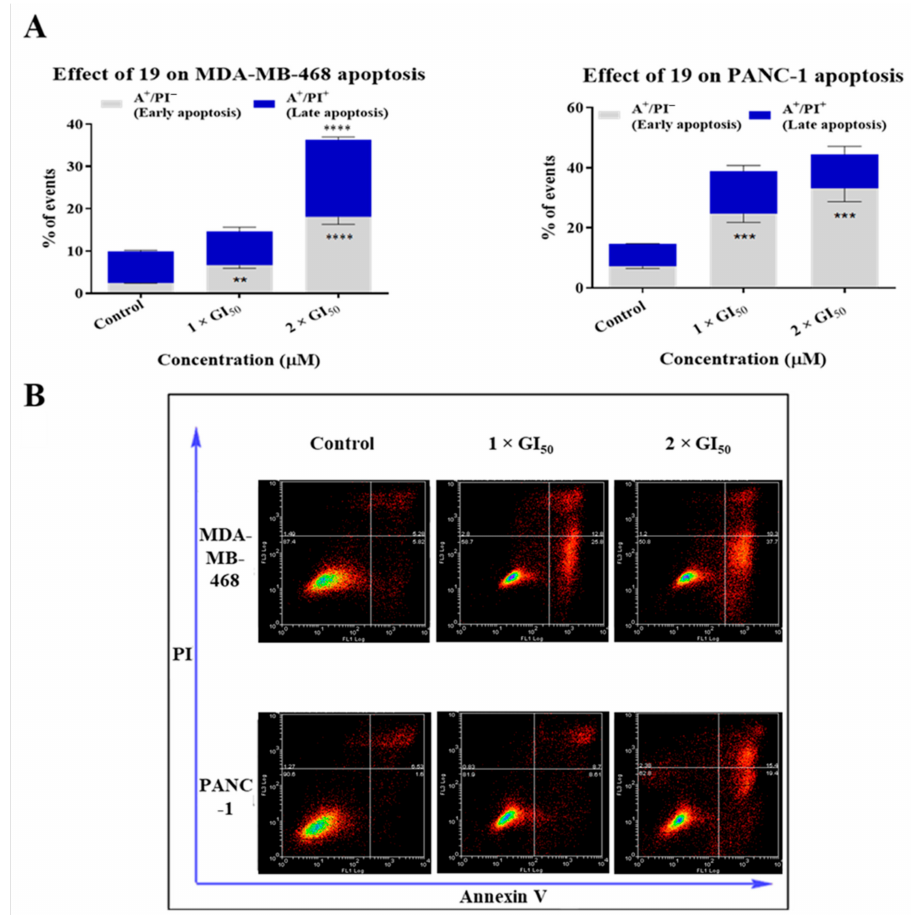
Figure 8. ( A ) Results of the annexin V/propidium iodide (PI) apoptosis assay showed that 19 induced apoptosis in MDA- MB-468 and PANC-1 cells after 24 h of treatment at concentrations of 1 × GI 50 and 2 × GI 50 . Total apoptosis comprises both early and late apoptotic populations. The experiment was repeated at least three times. Bars and error bars refer to mean ± SD. ** p < 0.01 vs. control, *** p < 0.001 vs. control, **** p < 0.0001 vs. control. ( B ) Representative apoptosis quadrant plots illustrating the apoptotic effects of 19 on MDA-MB-468 and PANC-1 cells.